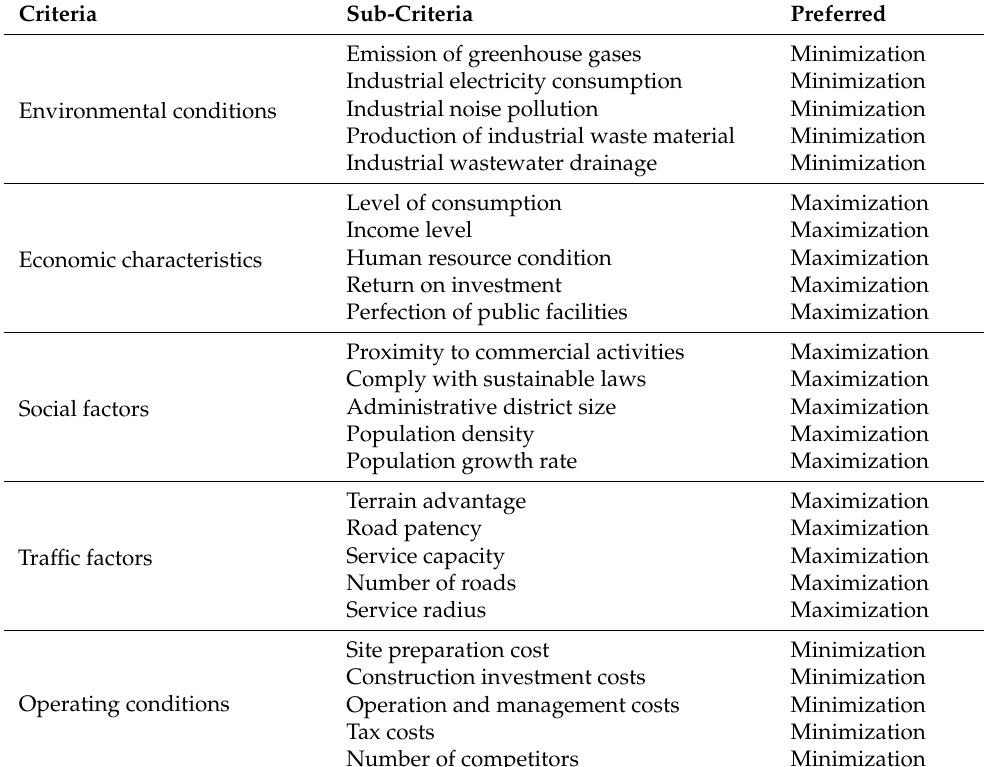
Table 1. Evaluation criteria system summarized from the aggregation of interrelated literature for site